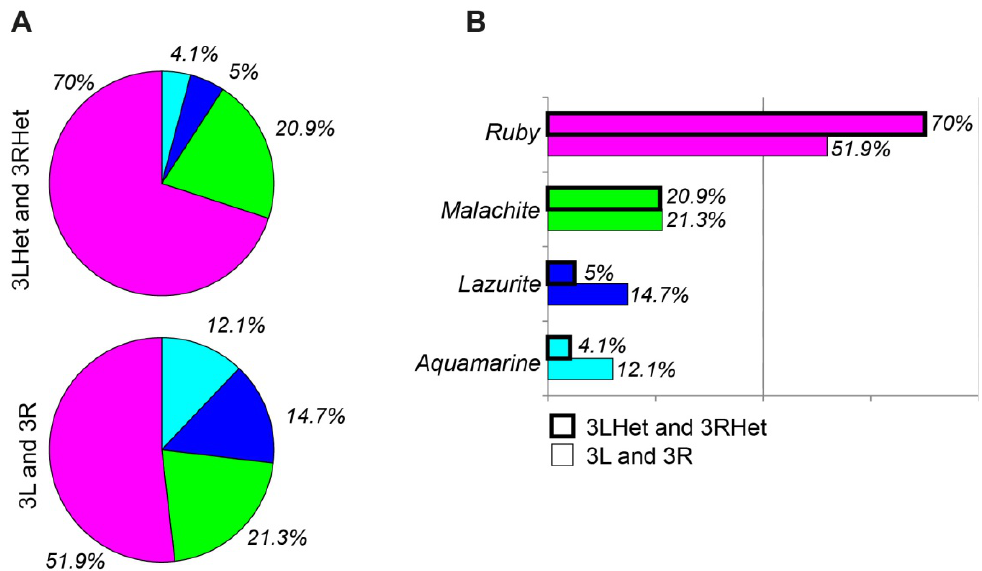
Figure 11. Percentages of four chromatin states in the D. melanogaster heterochromatic regions 3LHet and 3RHet and euchromatic regions 3L and 3R ( A ). Comparison of the proportions of each of the four chromatin states between the heterochromatic and euchromatic regions ( B ).